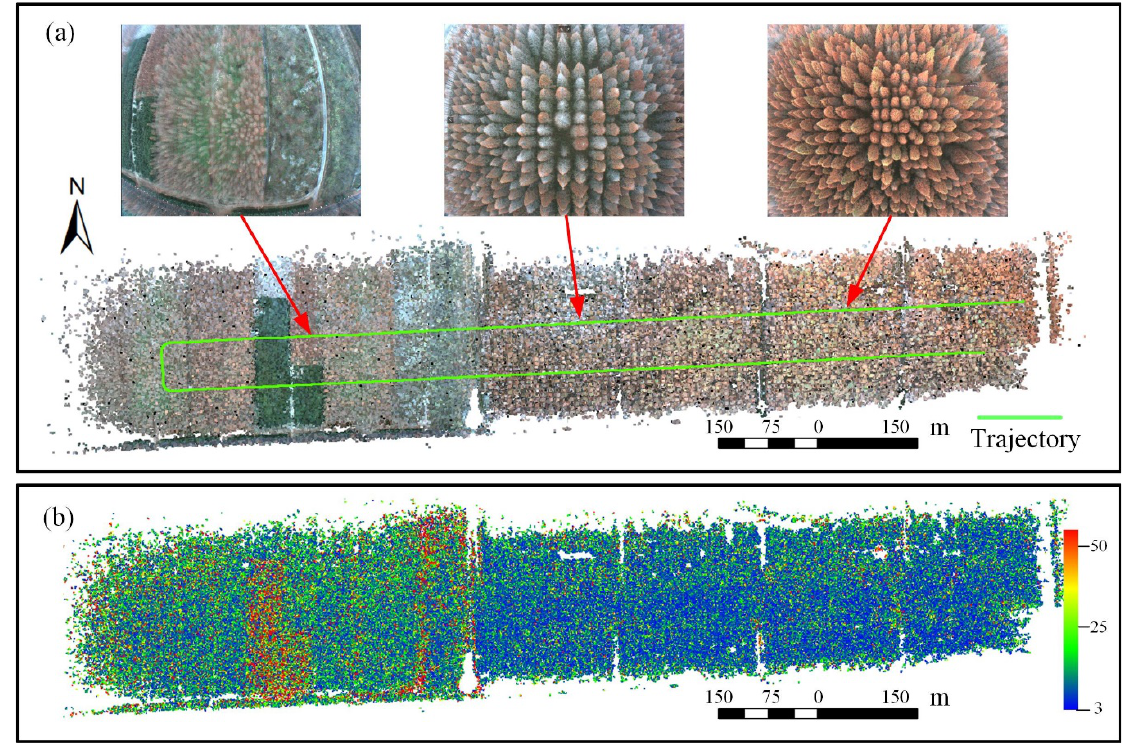
Figure 6. Trajectory estimation and observability of the tie points. ( a ) The trajectory, tie points, and three images captured by the low-cost ULS. ( b ) Observability of the tie points.